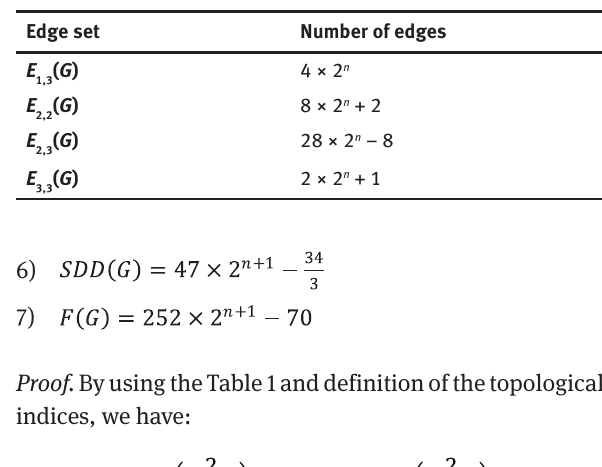
Table 1: Number of edges in each set of